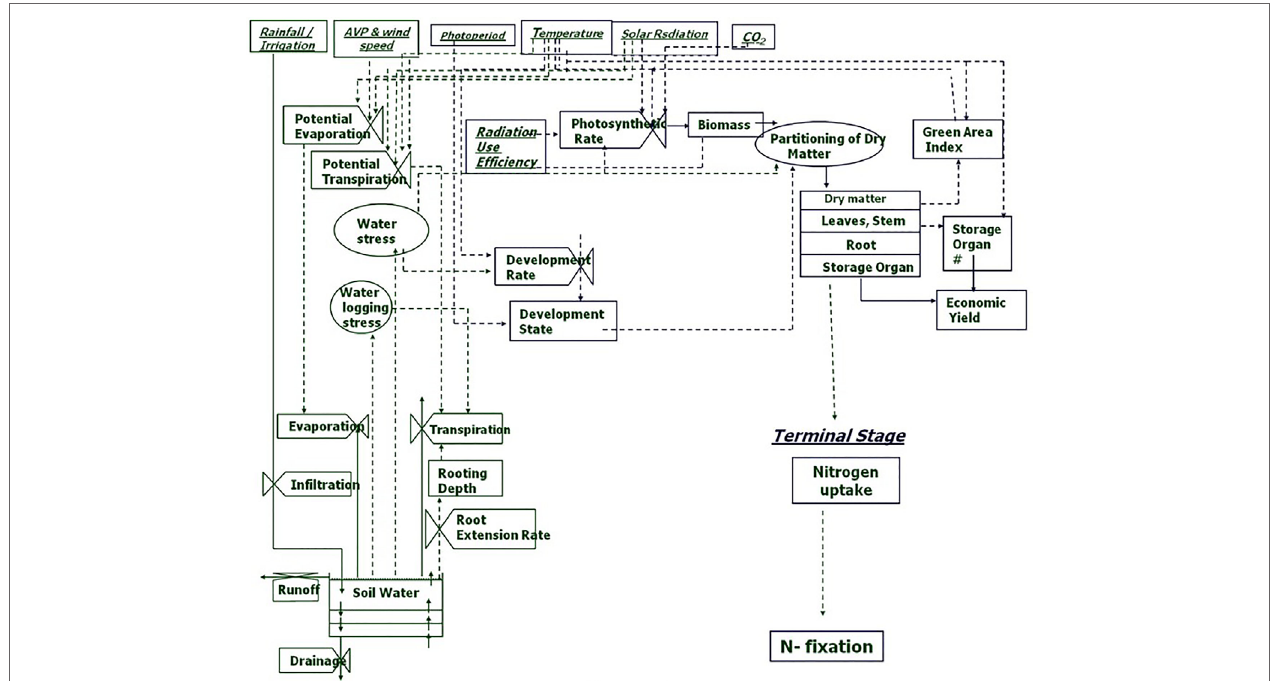
FIGURE 2 | Process chart of mungbean growth model (MungGro) [Biswas et al.,